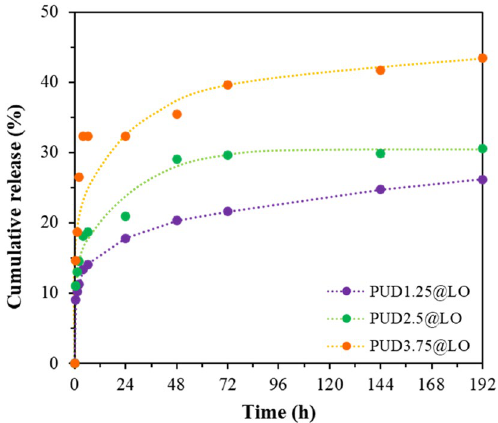
Figure 11. Release profiles of LO from PUD@LO nanoparticles at 37 °C in PBS (pH